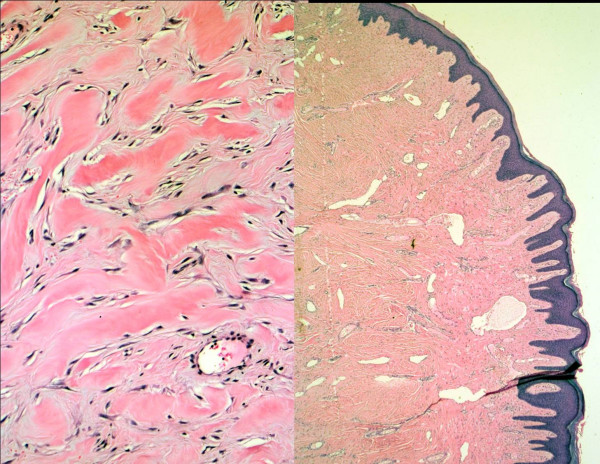
Low (right)- and high-power histology of excised keloid, showing characteristic grayish-colored lobular tissue with fibrous polypoid whorls.